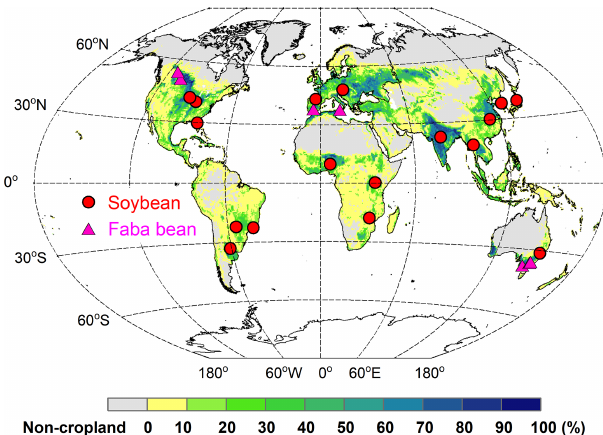
Figure 3. Spatial distribution of soybean (red circles) and faba bean (magenta triangles) sites used for BNF evaluation. The map back- ground is cropland fraction (%) averaged over 1996–2005 at the resolution of 0 . 5 ◦ × 0 . 5 ◦ , derived from the LUH2 dataset (Hurtt et al.,